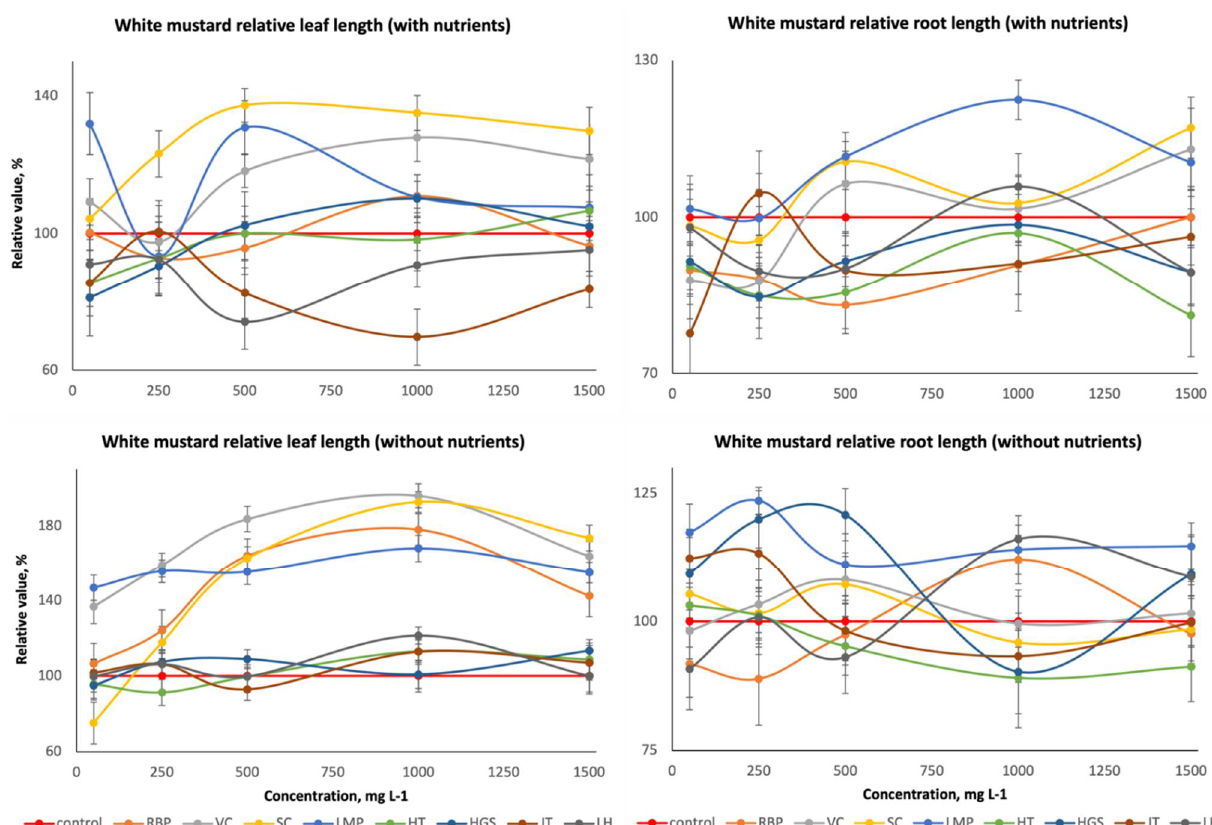
Figure 1. Relative changes in white mustard ( Sinapis alba ) shoot and root length over a concentration range of potassium humate solutions of different origins, with and without added nutrient solution. RBP = raised bog peat, VC = vermicompost, SC = soil compost, LMP = low moor peat, HT = Humin Tech potassium humate, HGS = Humic Growth Solutions potassium humate, JT = Jin Tai FA, LH = Lignohumate